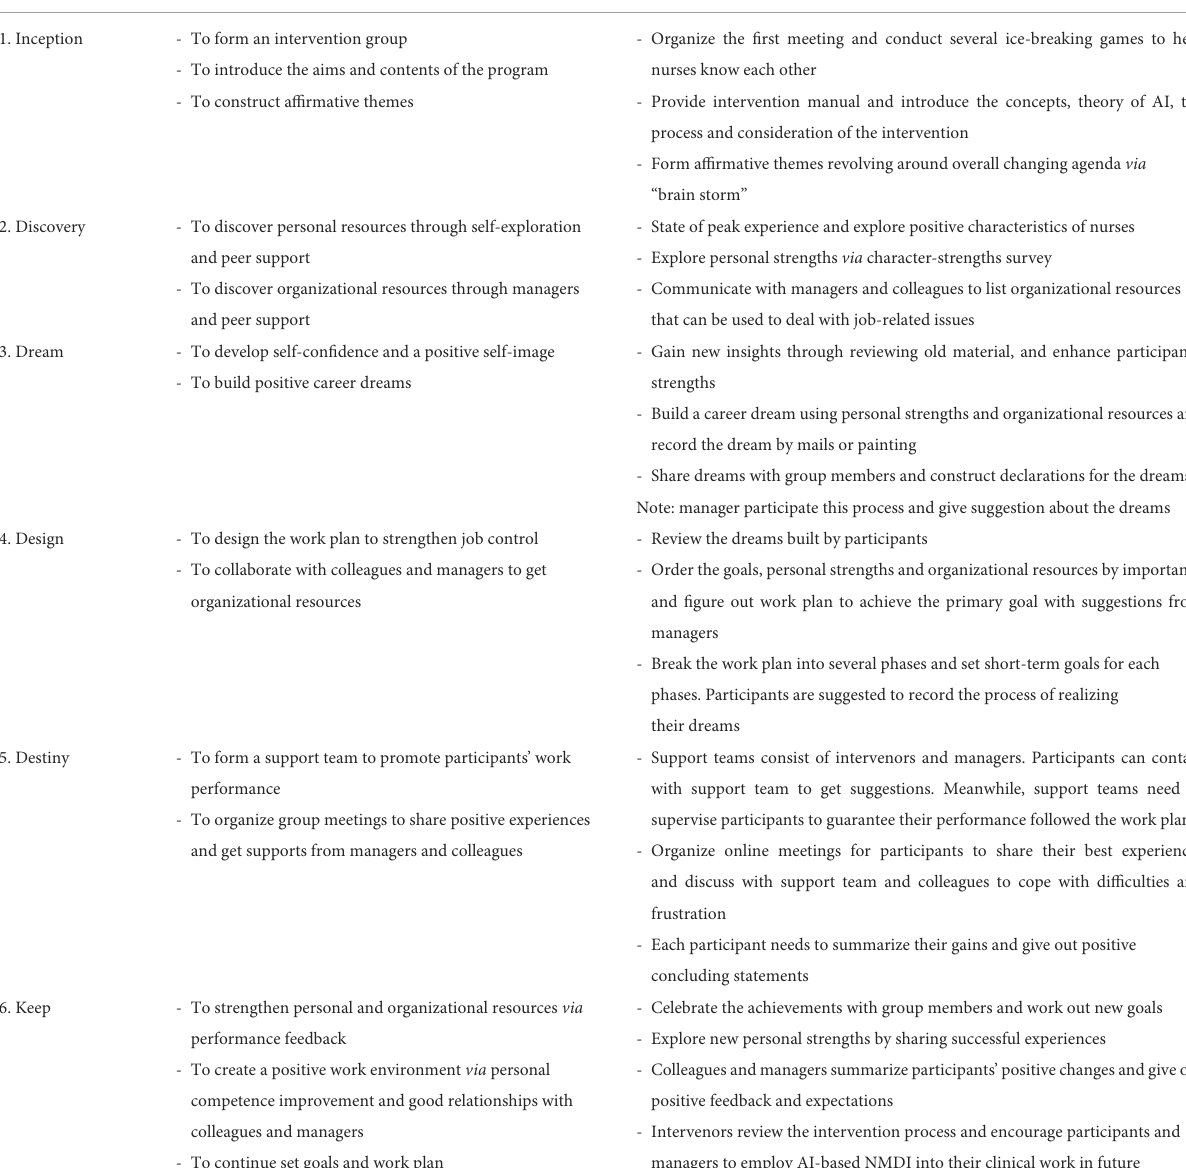
TABLE 2 Titles, aims and contents of the AI-based NMDI program